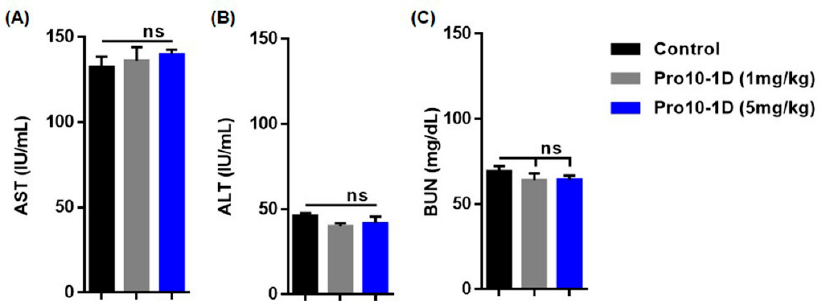
Figure 11. Pro10-1D exerts nontoxic effects in vivo. The representative graph indicates ( A ) aspartate aminotransferase (AST), ( B ) alanine aminotransferase (ALT), and ( C ) blood urea nitrogen (BUN) levels of mice treated with Pro10-1D (1 mg/kg and 5 mg/Kg) for 24 h. Control mice only received phosphate-buffered saline. Data are presented as the mean ± SEM (5 mice/group). Statistical analysis was performed by one-way ANOVA ( Tukey’s post hoc test ; ns, not significant).